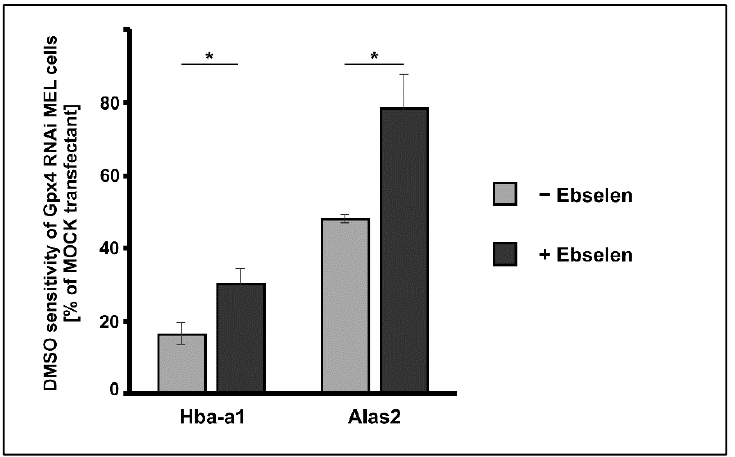
Figure 6. Delay of DMSO-induced erythroid differentiation in Gpx4 deficient MEL cells was partially rescued by the se- leno-organic compound ebselen that functions as Gpx mimetic. MEL cells, which were stably transfected with a Gpx4 siRNA plasmid (Gpx4 RNAi) or with a corresponding control vector (MOCK RNAi) were seeded in culture dishes (10 4 cells/mL) and cultured in the absence or presence of 5 µM ebselen. Cells were cultured at 37 °C for 3 days without or with 2% DMSO and total RNA was extracted. The steady-state concentrations of Hba-a1 mRNA, Alas2 mRNA and Gapdh mRNA were quantified by qRT-PCR using specific amplification primers. DMSO sensitivity in the different incubation samples was determined and the DMSO sensitivity of the Gpx4 RNAi transfectant was shown relative to that of the MOCK transfectant (see Material and Methods). Significances were calculated using the Student’s t -test, * p <